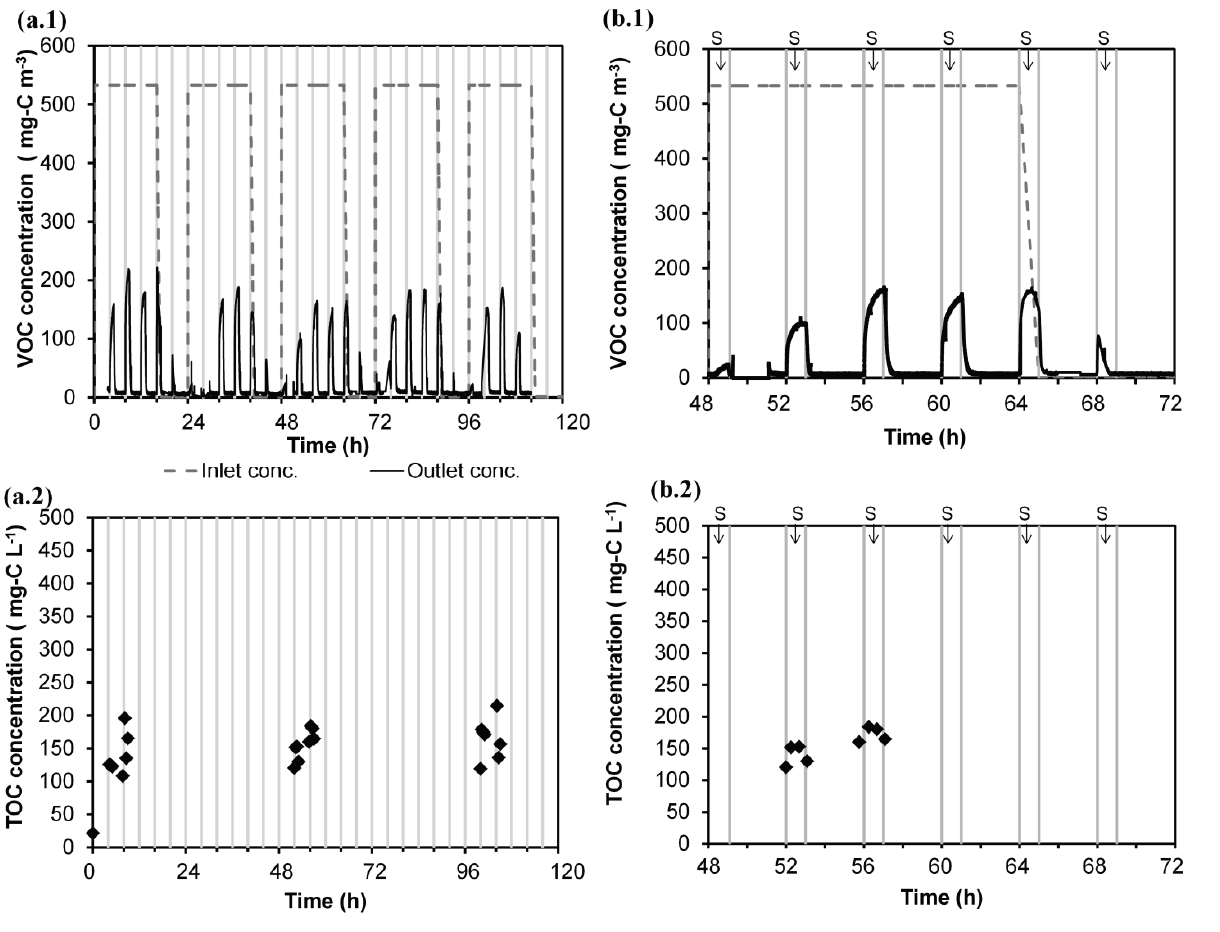
Figure 2. Experimental data of Run 1 (Monday to Friday), where each central line denotes a spraying: ( a.1 ) concentration of VOC in the gas phase; ( a.2 ) concentration of the dissolved carbon in the water tank. Wednesday results, where S denotes the spraying periods: ( b.1 ) concentration of VOC in the gas phase; ( b.2 ) concentration of the dissolved carbon in the water